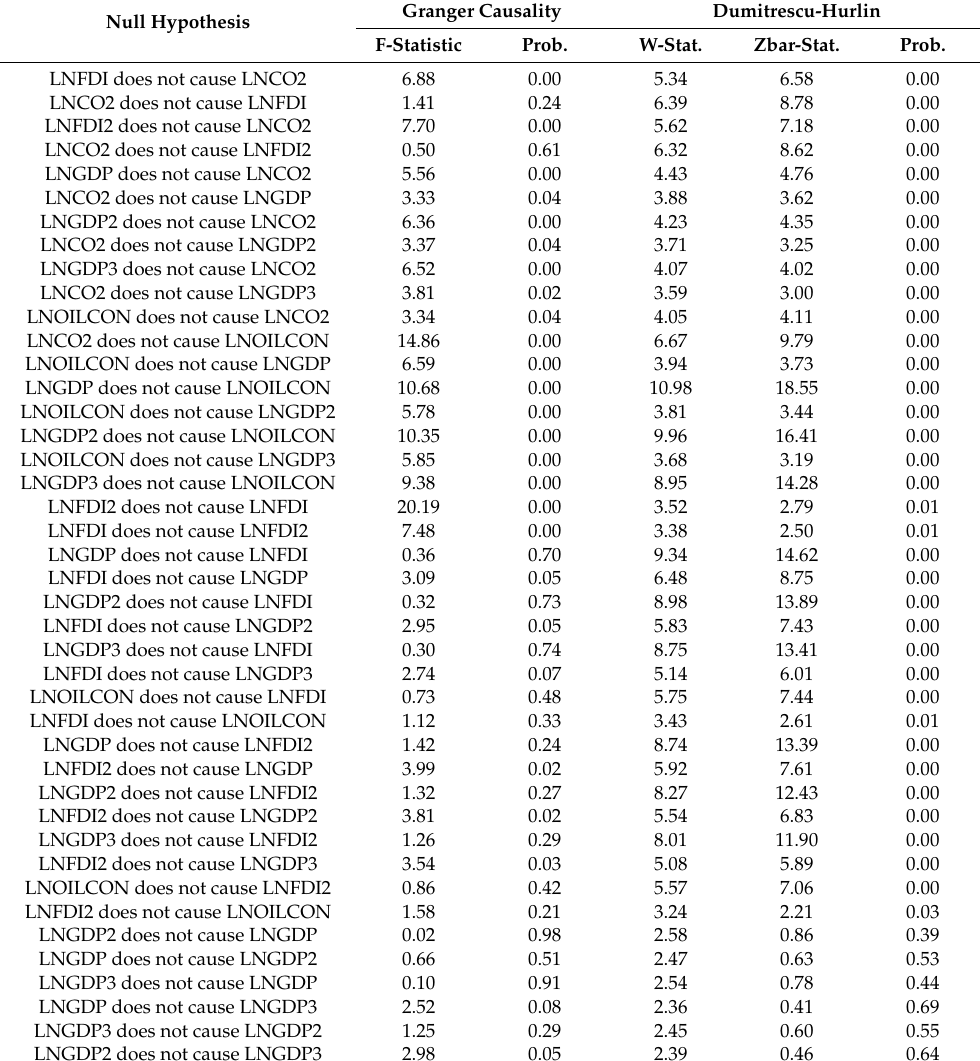
Table A1. Causality test results from both approaches for all variables.